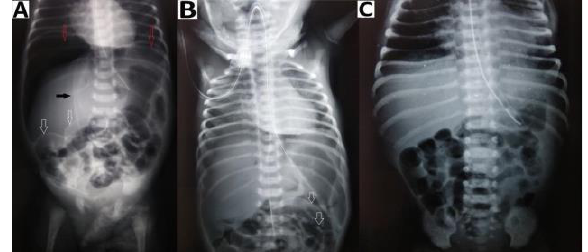
Figure 1: Abdominal radiographs (erect) (A) showing pneumoperi- toneum with gas under the diaphragm (red arrows), Rigler sign (white arrows) and outlining of falciparum ligament (black arrow); supine image (B) showing Rigler sign (white arrows); erect image (C) showing resolution of pneumoperitoneum after abdominal drain placement.